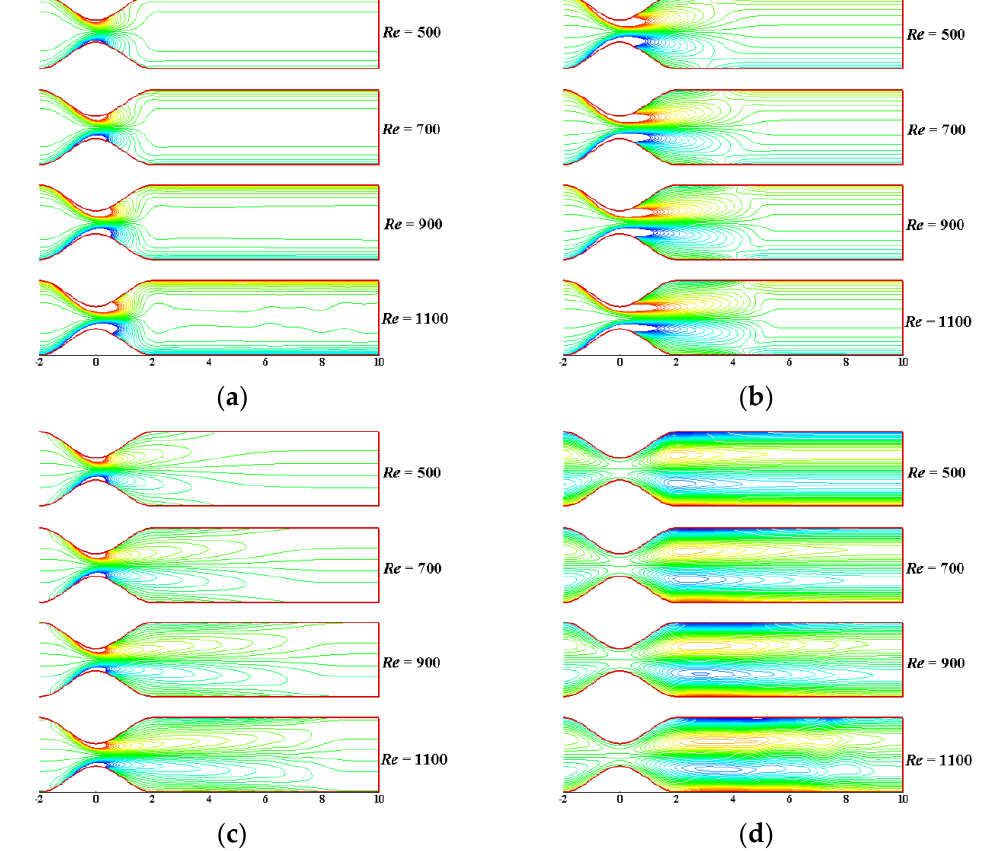
Figure 12. Vorticity contours of the pulsatile flow for different values of Re with M = 5, St = 0.02, and K = 0.6 at ( a ) t = 0, ( b ) t = 0.25, ( c ) t = 0.50, and ( d ) t =